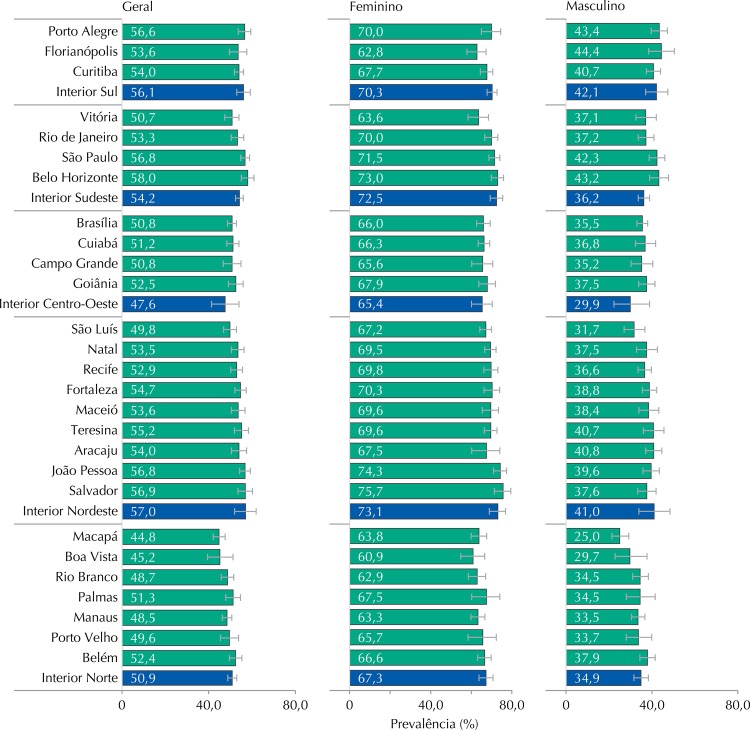
Prevalência (%) de inatividade física (< 300 min/semana) em adolescentes das 27 capitais brasileiras (barras verdes) e conjunto dos municípios com mais de 100 mil habitantes, não capitais das regiões, por sexo. ERICA, 2013-2014.